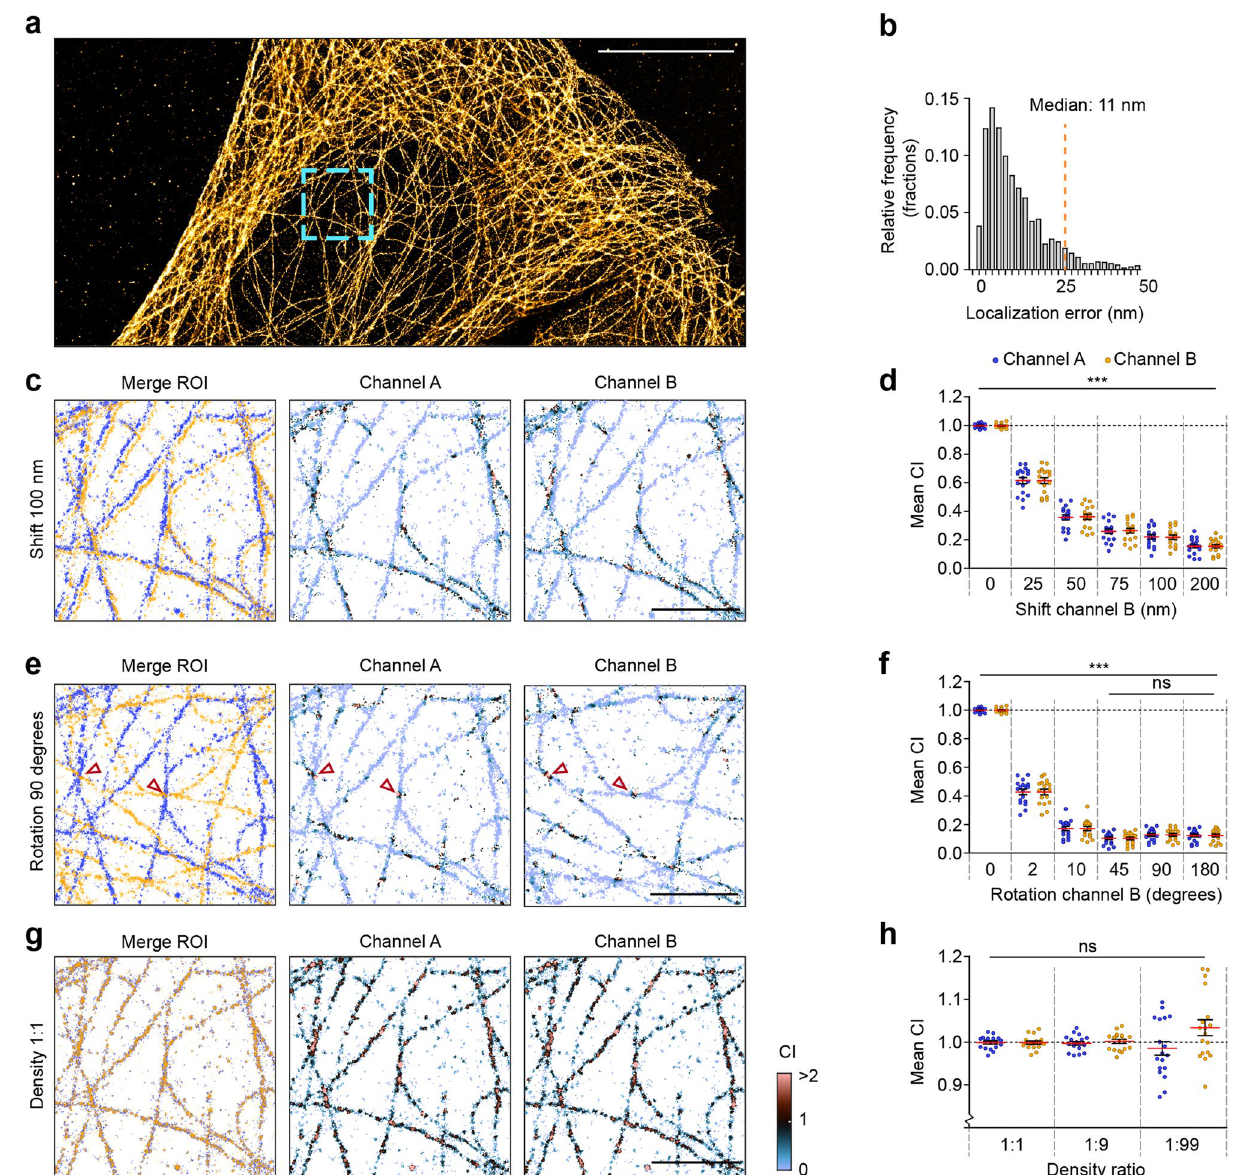
Figure 3. Application and validation of co-localization index on a biological sample. ( a ) dSTORM imaging was performed on U2OS cells labeled with anti-alpha-tubulin antibodies. Shown is a rendered reconstruction of all localizations. Scale bar, 10 μm. ( b ) Frequency distribution of the localization precision across all localizations. Localizations with localization precision > 25 nm (orange line) were removed from the dataset. Bin size, 2 nm. ( c ) Example ROI in which channel B is shifted 100 nm to the right relative to channel A. ( d ) Graph showing mean co-localization with varying amounts of shift. ( e ) Example in which channel B is rotated 90 degrees relative to channel A. Two microtubule cross-points are indicated with red arrows Scalebar in (c, e, g), 2 μm. ( f ) Graph showing mean co-localization for individual ROIs with varying degree of rotation of channel B. ( g ) The localization dataset was randomly split into two channels (A, blue; B, yellow), with varying density ratios. Shown is an example ROI, indicated with a blue box in (a) with a 1:1 ratio. Also shown are the maps color-coded for the co-localization index. ( h ) Graph showing mean co-localization index for individual ROIs with varying density ratios. N = 18 ROIs from 3 cells. Data are represented as means ± SEM. Ns, not significant, *** P < 0.001, ANOVA. ROI region of interest, CI co-localization